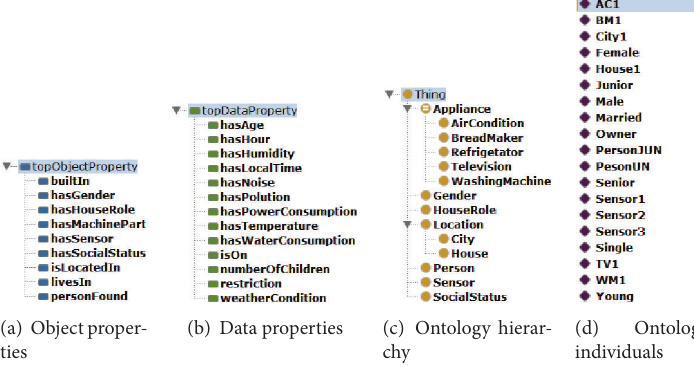
Figure 3: An example of the ontology properties, the hierarchical structure, and the individuals used for our